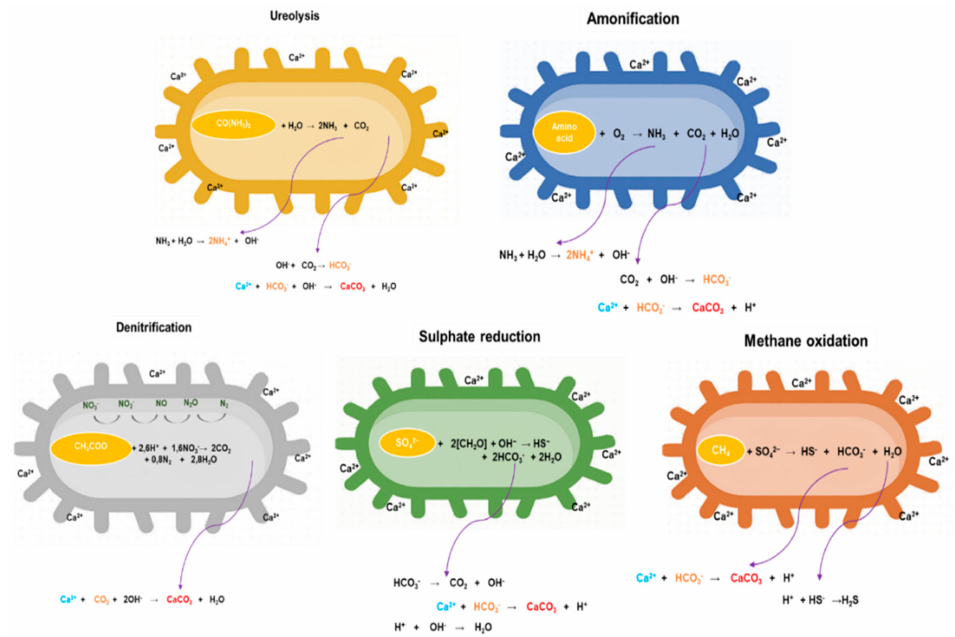
Figure 2. Metabolic pathways for effective bacterially induced carbonate